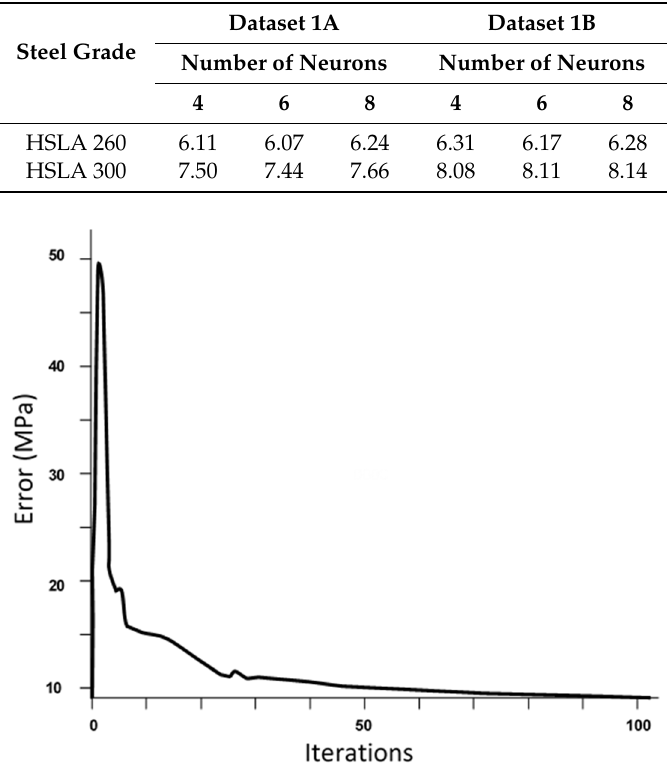
Figure 6. Evolution of the error with the number of iterations.